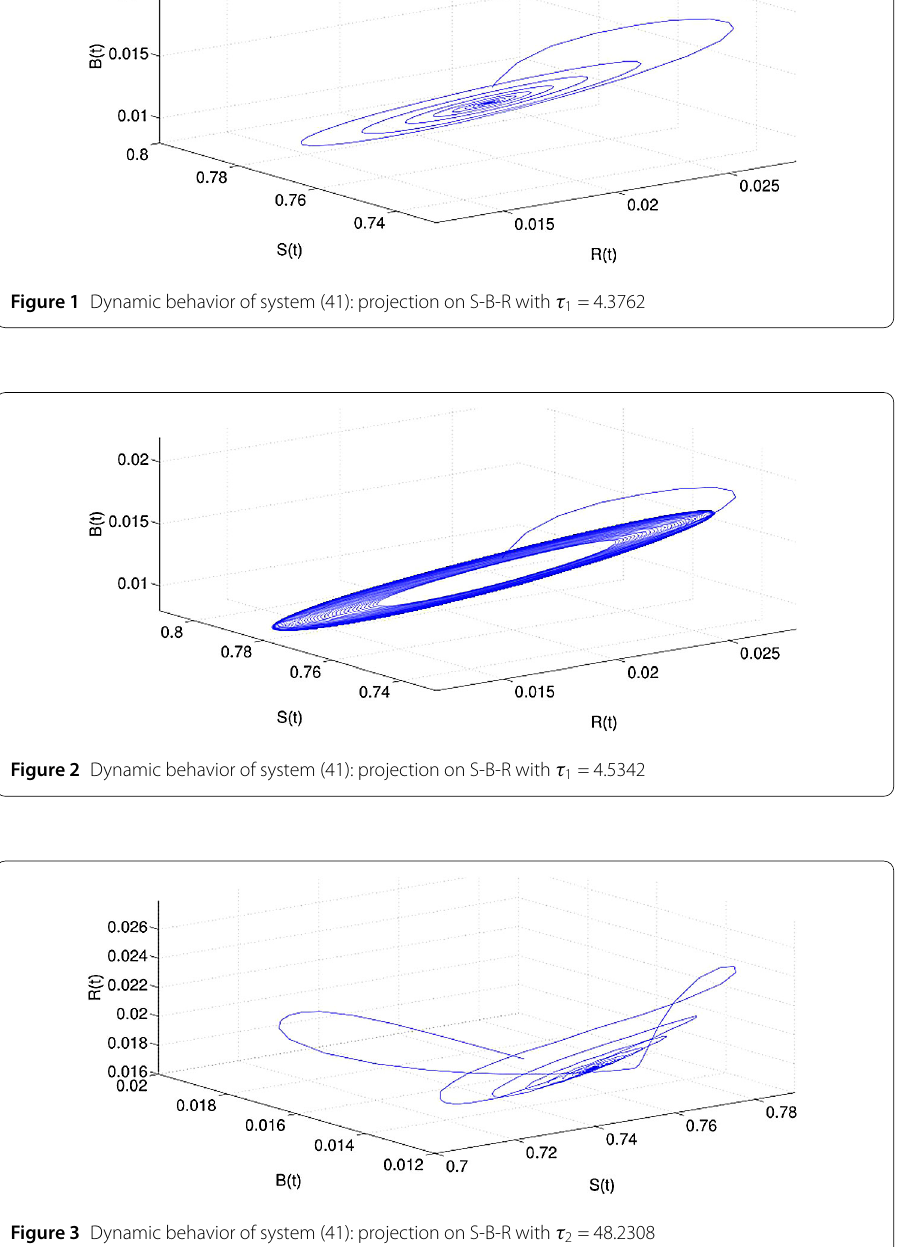
Figure 3 Dynamic behavior of system (41): projection on S-B-R with τ 2 =